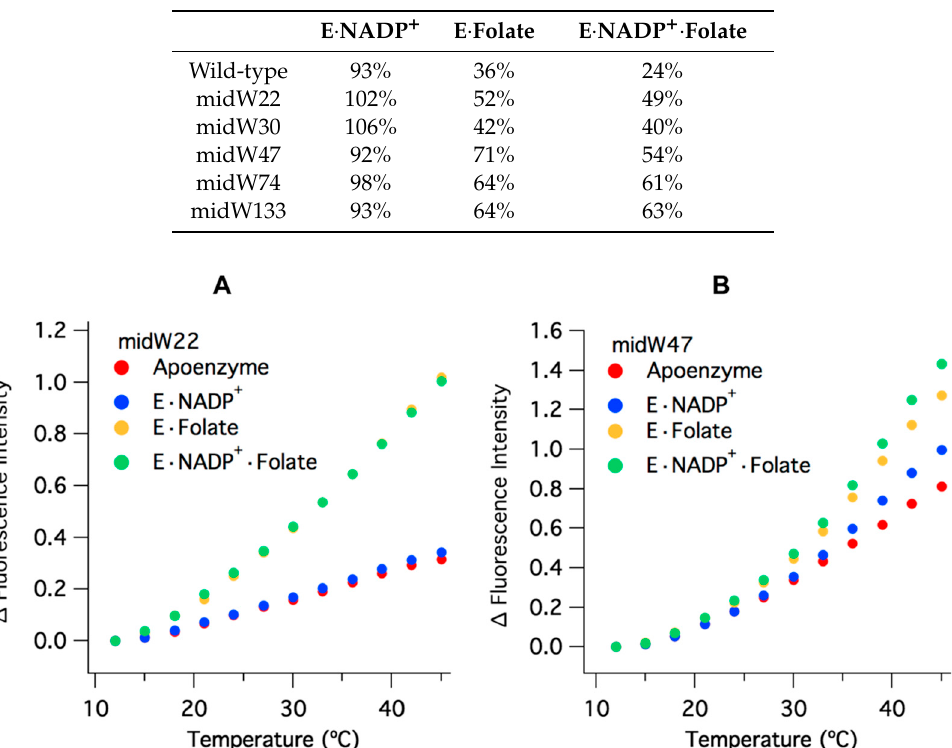
Figure 5. Change in fluorescence intensity versus temperature, corrected for the intrinsic temperature dependence of Trp fluorescence, of ( A ) midW22 and ( B ) midW47 (3 μ M enzyme with 6 μ M folate and/or 6 μ M NADP + ). All complexes demonstrate an increase in fluorescence with increasing temperature. The change in intensity for the binary complex with NADP + and apoenzyme compared to the two folate bound complexes is similar for midW22, which is expected based on the similarities in the spectra of apoenzyme/E·NADP + and E·Folate/E·NADP + ·Folate. Conversely, each midW47 complex has a slightly different temperature dependence, reflecting the difference in Trp fluorescence intensity for the different ligand bound states.